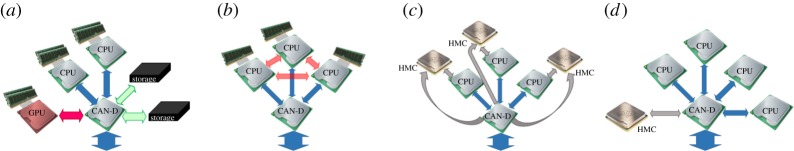
The flexibility of CAN architecture: examples of several different implementation schemes. (a) Centralized network fabric, where all intra-server communication is through CAN-D. (b) Distributed network fabric, where only part of the intra-server communication is through CAN-D. (c) A multi-controller memory implementation, where both CAN-D and CPU devices are attached to the RAM. (d) A centralized memory topology, where all devices access the RAM through CAN-D. The number and type of devices connected to CAN-D vary as well. (Online version in colour.)